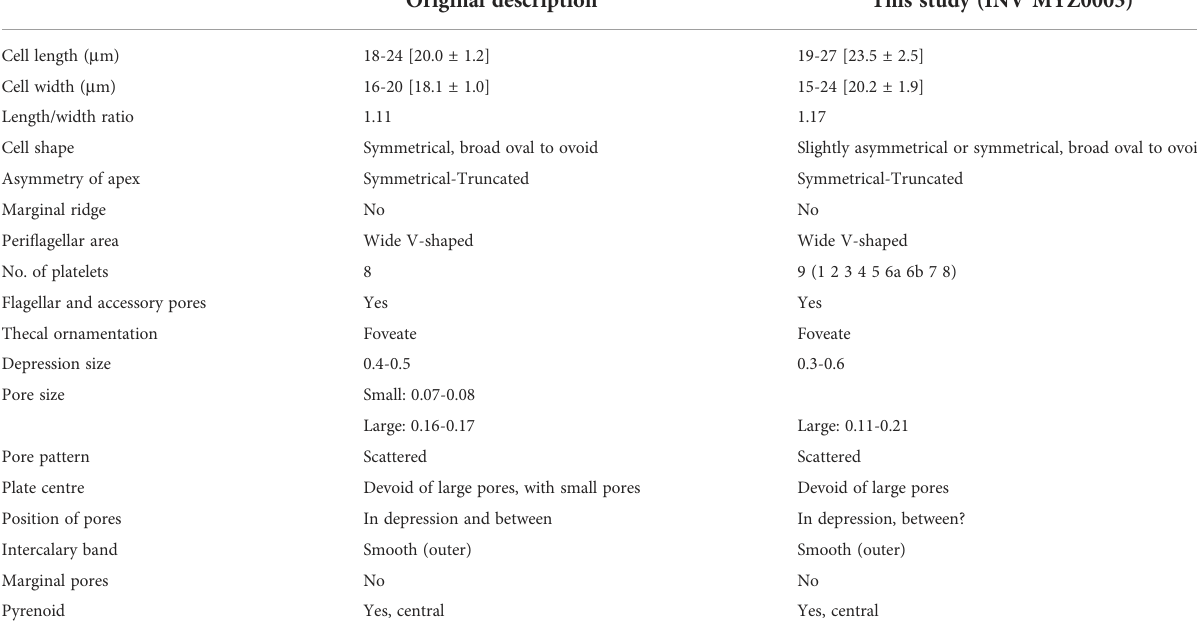
TABLE 2 Comparison of morphometric (min – max [mean ± SD]) and morphological features between the strain INV MYZ0003 and the original description for P. borbonicum (Ten-Hage et al.,